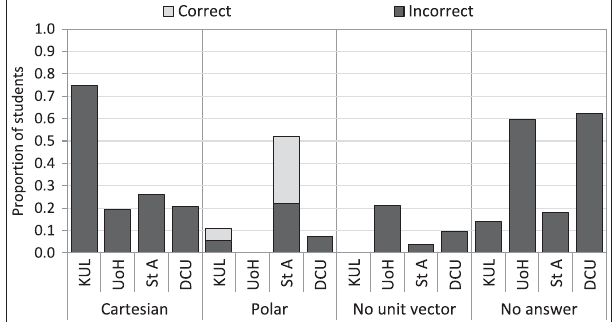
FIG. 12. Proportion of correct responses, depending on the chosen coordinate system, to question 3(b) [Fig.